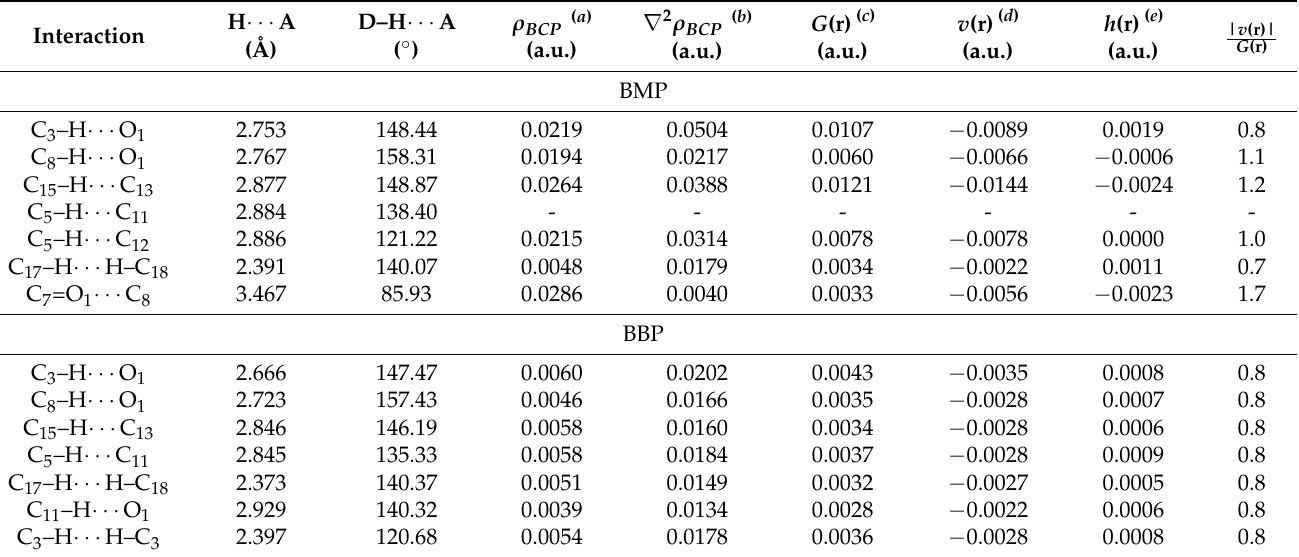
Table 3. Hydrogen-bond geometry and topological parameters calculated for the BMP and BBP molecular interactions at the bond critical